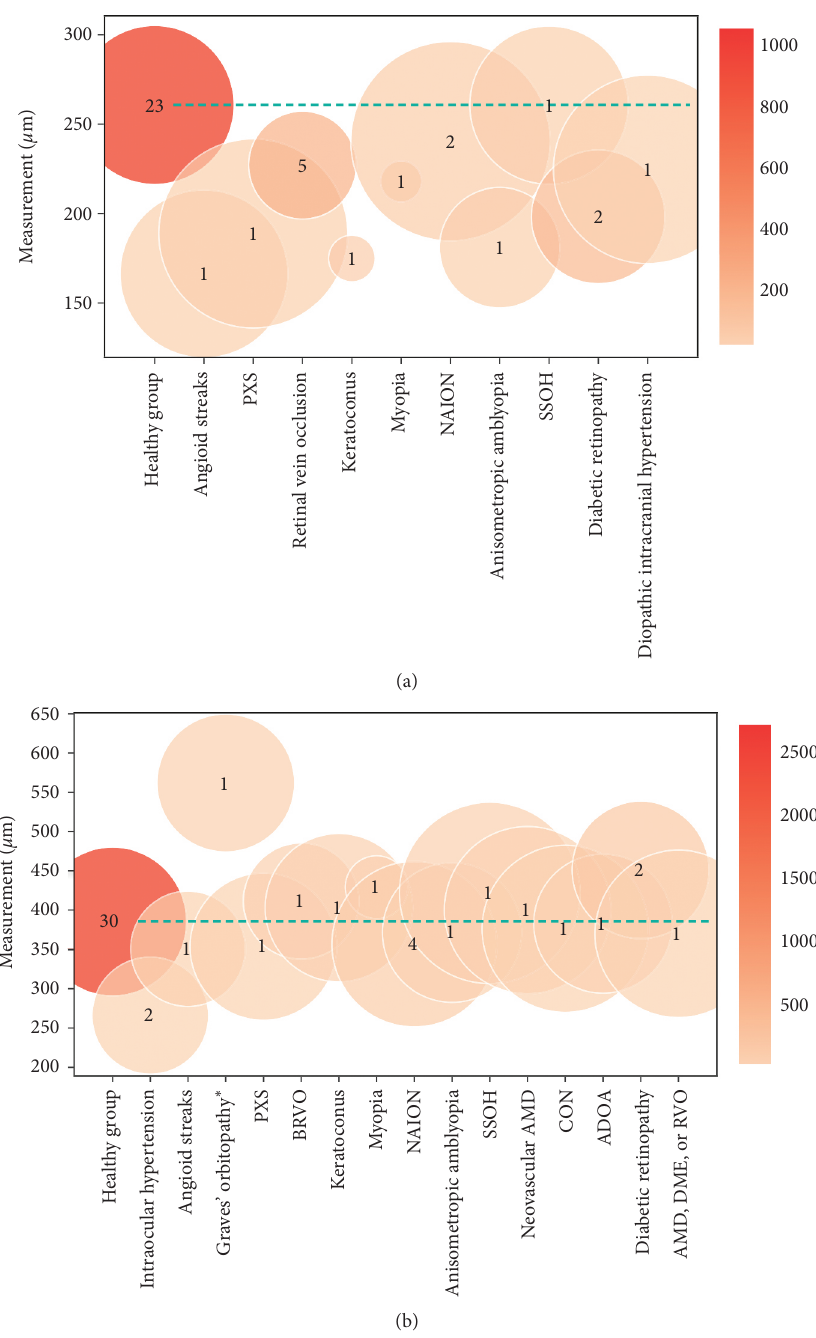
Figure 6: Comparison of lamina cribrosa (a) thickness (LCT) and (b) depth (LCD) for the ophthalmic disease group. The dashed green line represents the mean for the healthy population. Only pathologies that included more than 20 eyes among all articles are considered for the analysis. ∗ With proptosis and/or compressive optic